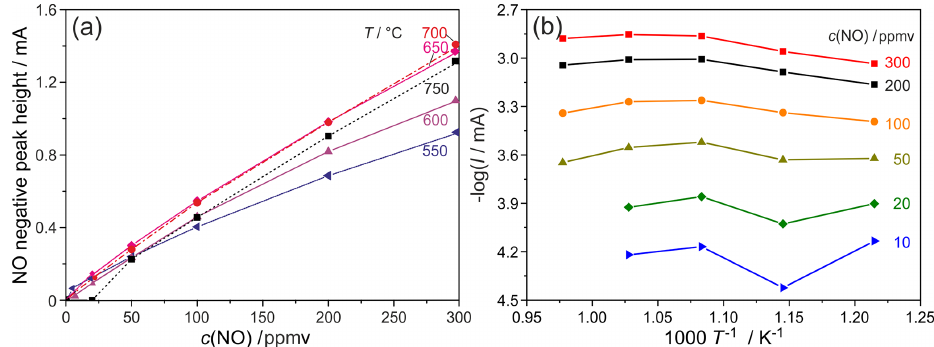
Figure 4. Dependence of NO peak heights on the NO concentration at different sensor temperatures (a) and Arrhenius dependency (b) . Flow rate = 10sccm; c (O 2 ) = 0 . 2ppmv.